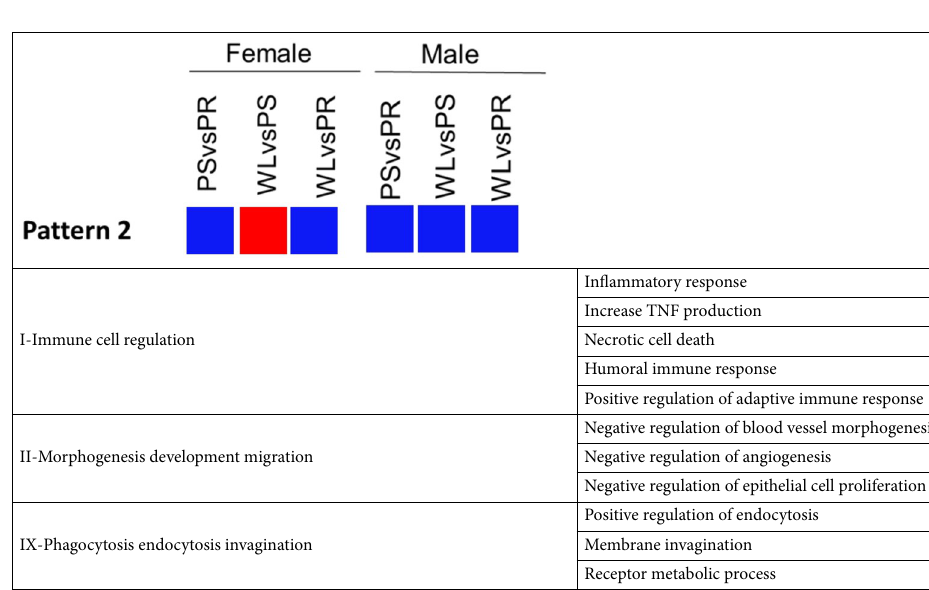
Table 2. Summary of clusters and gene sets included in the pattern 2 for the renal IRI time